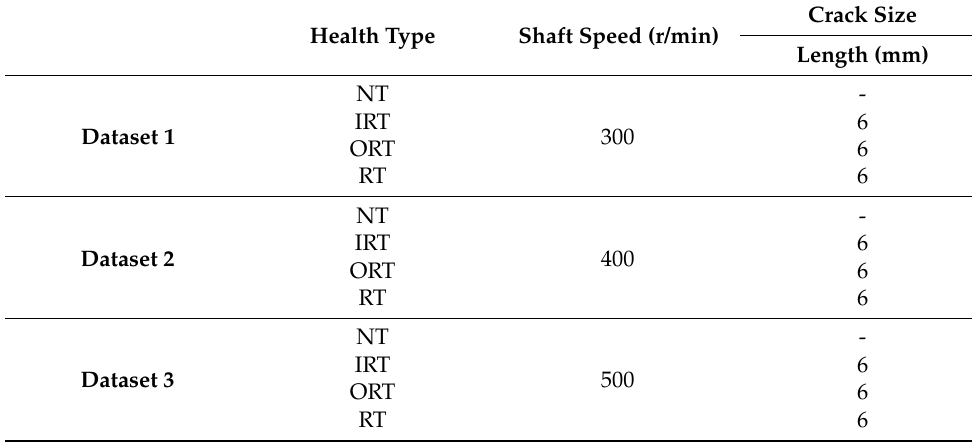
Table 3. Details of the dataset from the self-designed testbed used in case study 2.